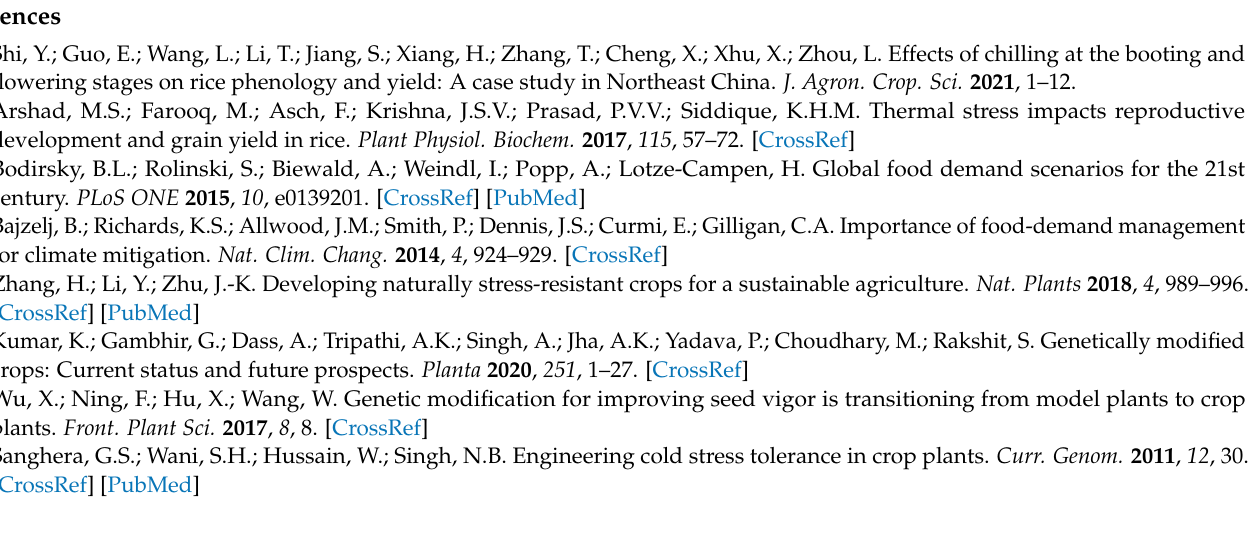
Figure S4: Distribution analysis of four cold stress tolerance response phenotypes for 370 RDP1 accessions, Figure S5: Distribution analysis of individual LTSS and EL activity phenotypes for three trials, Figure S6: Distribution analysis of individual CAT and ANT activity phenotypes for three trials, Figure S7: Box plots of mean values for CAT activity (A) and ANT activity (B) of 14-day-old seedlings for a subset of 70 RDP1 accessions grown under warm temperature (28 ◦ C day/25 ◦ C night) conditions, Table S1: Means, standard deviation, and variances of individual trials for four phenotyping assays using 370 RDP1 O. sativa accessions after a 7-day-10 ◦ C chilling treatment, Table S2: Summary of 120 quantitative trait loci (QTL) identified by GWAS mapping for four cold stress tolerance response traits using 370 RDP1 accessions, Table S3: Positions of published QTL overlapping with the 20 MP QTL identified in this GWAS mapping